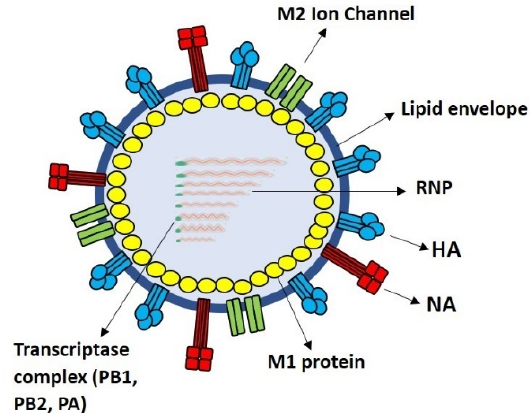
Figure 1. The M2 ion channels are present in small amounts on the surface of an influenza virion. They are shielded by neighboring HA and NA glycoproteins and hence are less prone to antigenic changes and are more conserved.